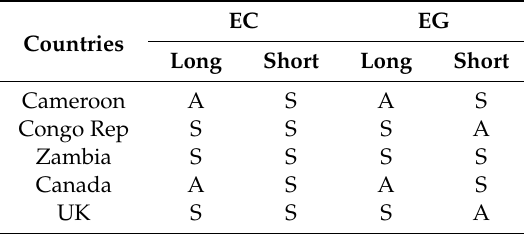
Table 10. Distribution of symmetric and asymmetric